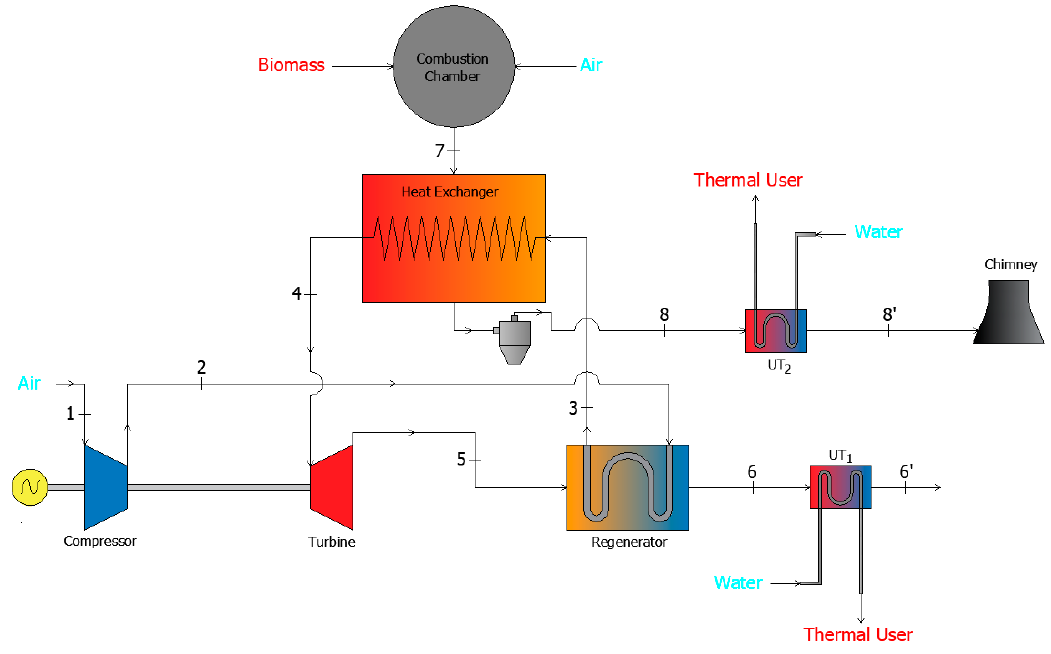
Figure 10. Scheme of the analysed CHP plant.